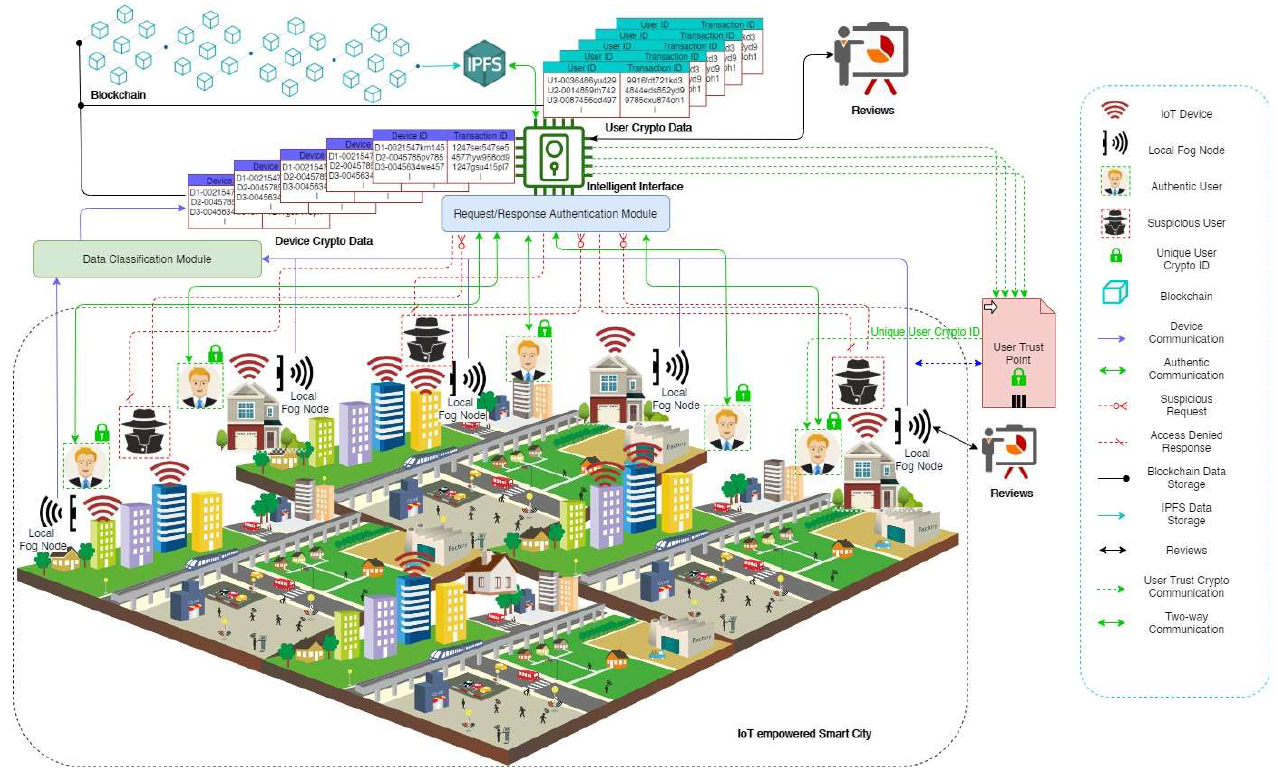
Figure 4. A conceptual framework for IoT and blockchain-empowered smart city.